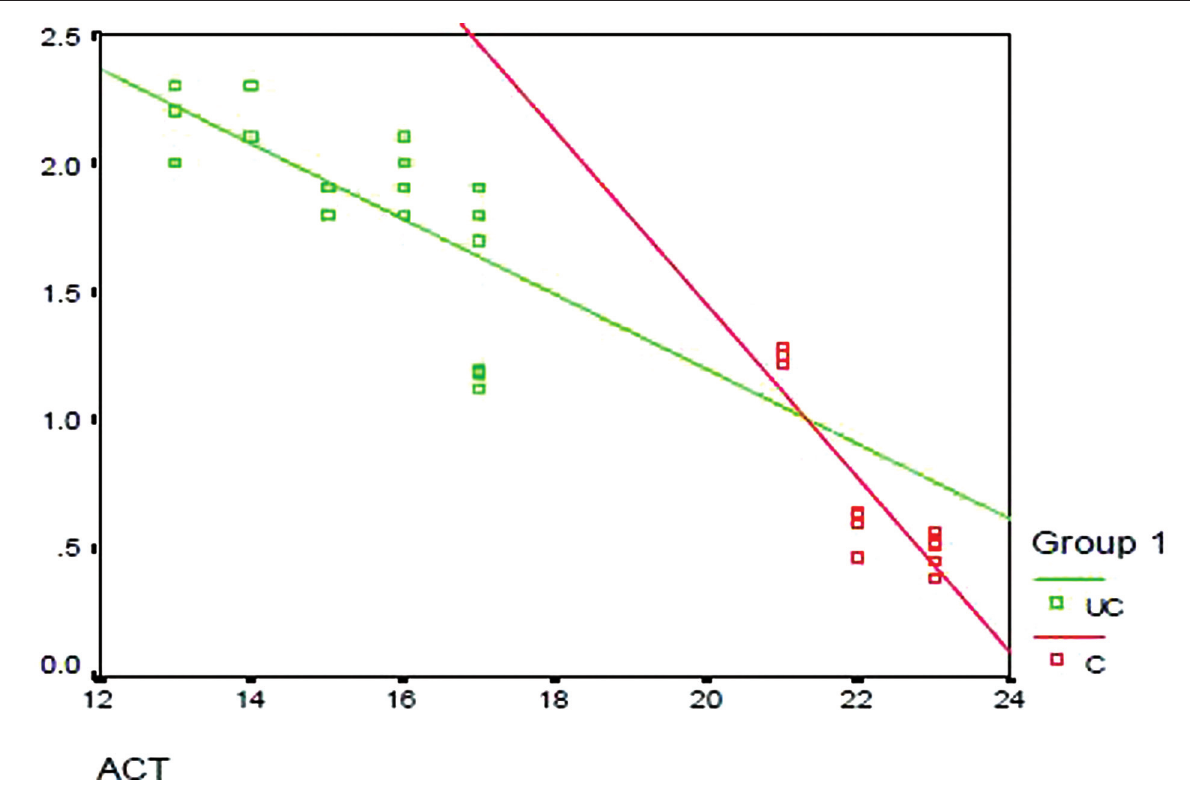
Correlation between R5 – 20 and asthma control test in both groups.